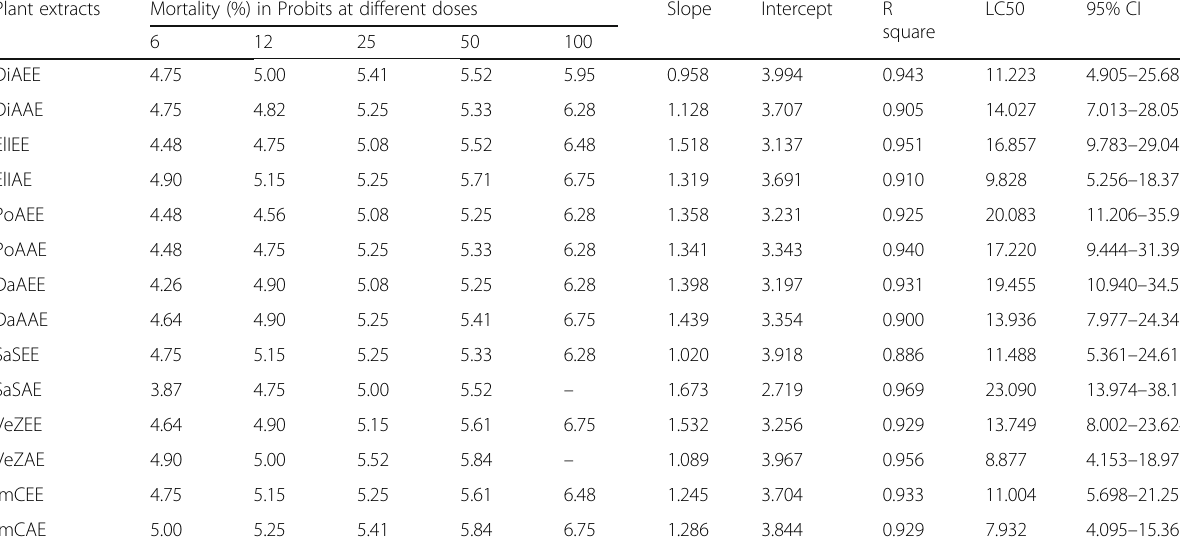
Table 4 Percentage mortality of brine shrimps in probits at five different concentrations and respective LC50 values Plant